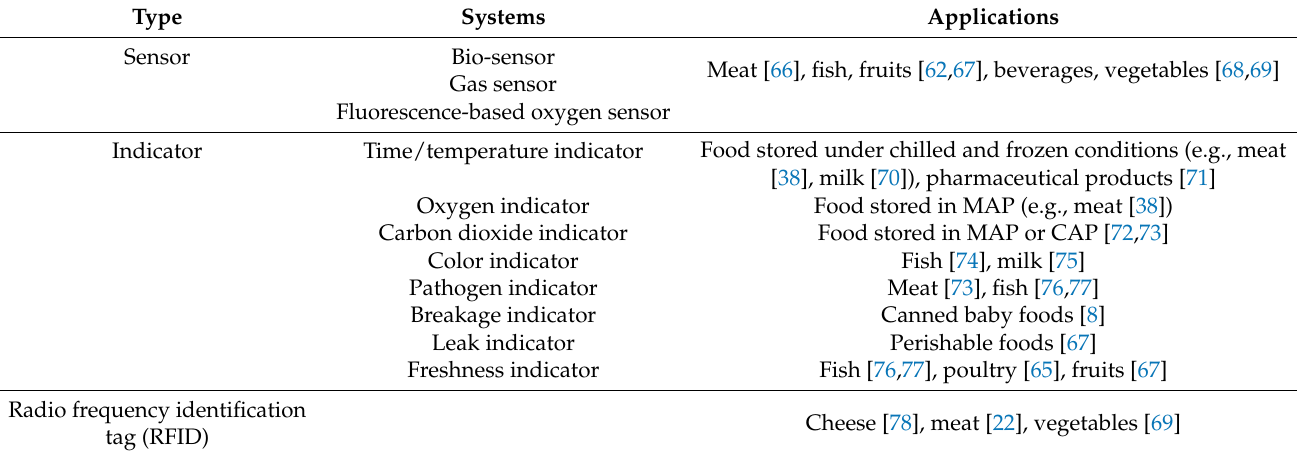
Table 2. Different types of intelligent packaging.